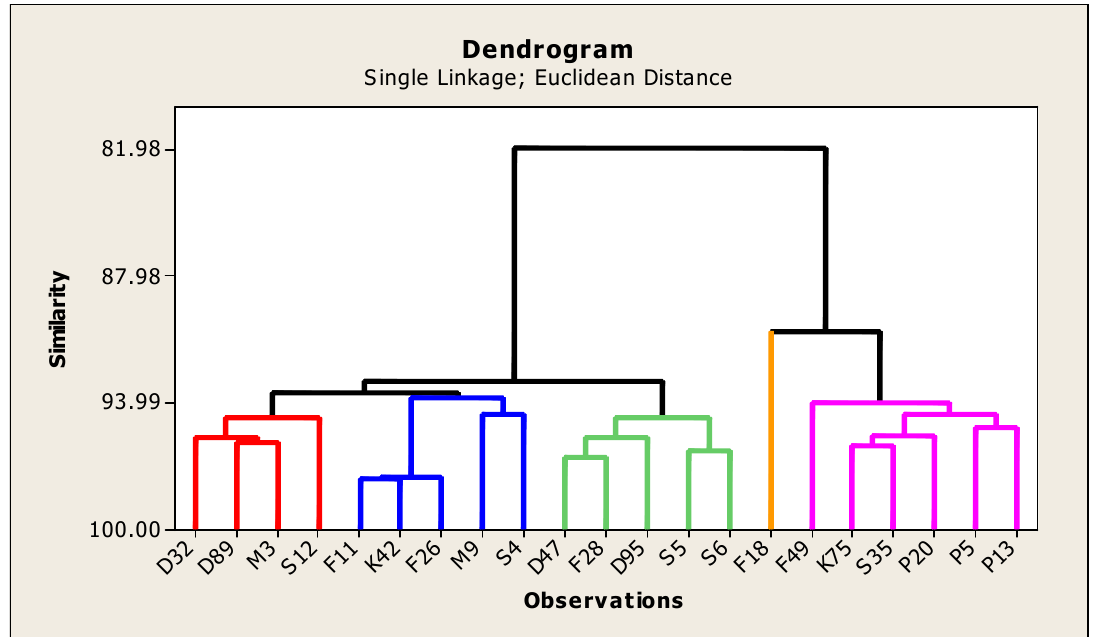
Figure 9. Dendrogram showing the distance among twenty-one genotypes of alfalfa based on yield components, forage yield and quality traits. Table 8. Summary of cluster analysis shows the twenty-one genotypes of alfalfa. Cluster